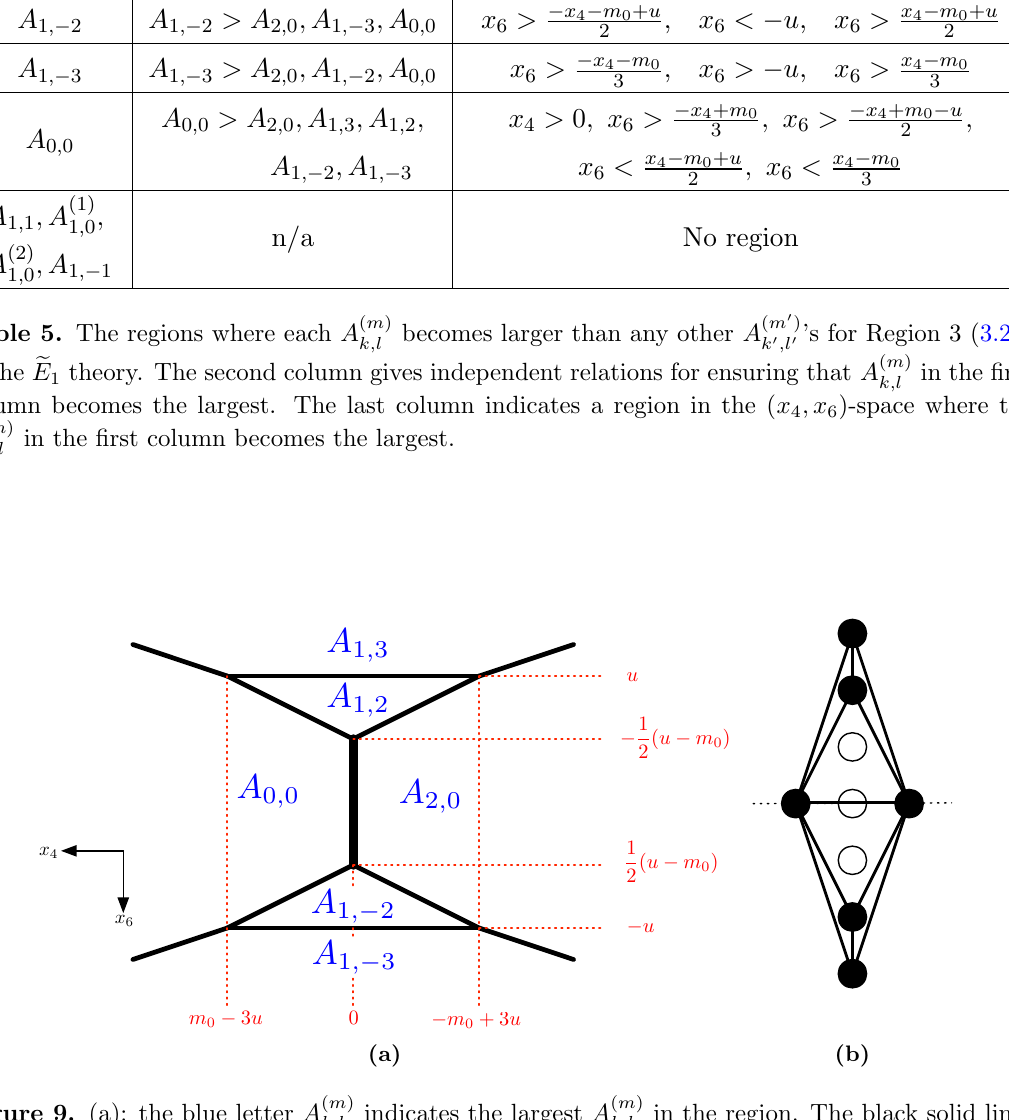
Figure 9. (a): the blue letter A ( m ) are the boundaries of those regions and give the 5-brane web in the decompacti(cid:12)cation limit of the E 1 curve in Region 3 (3.22). (b): the toric-like diagram of the by the web in (cid:12)gure (a). e